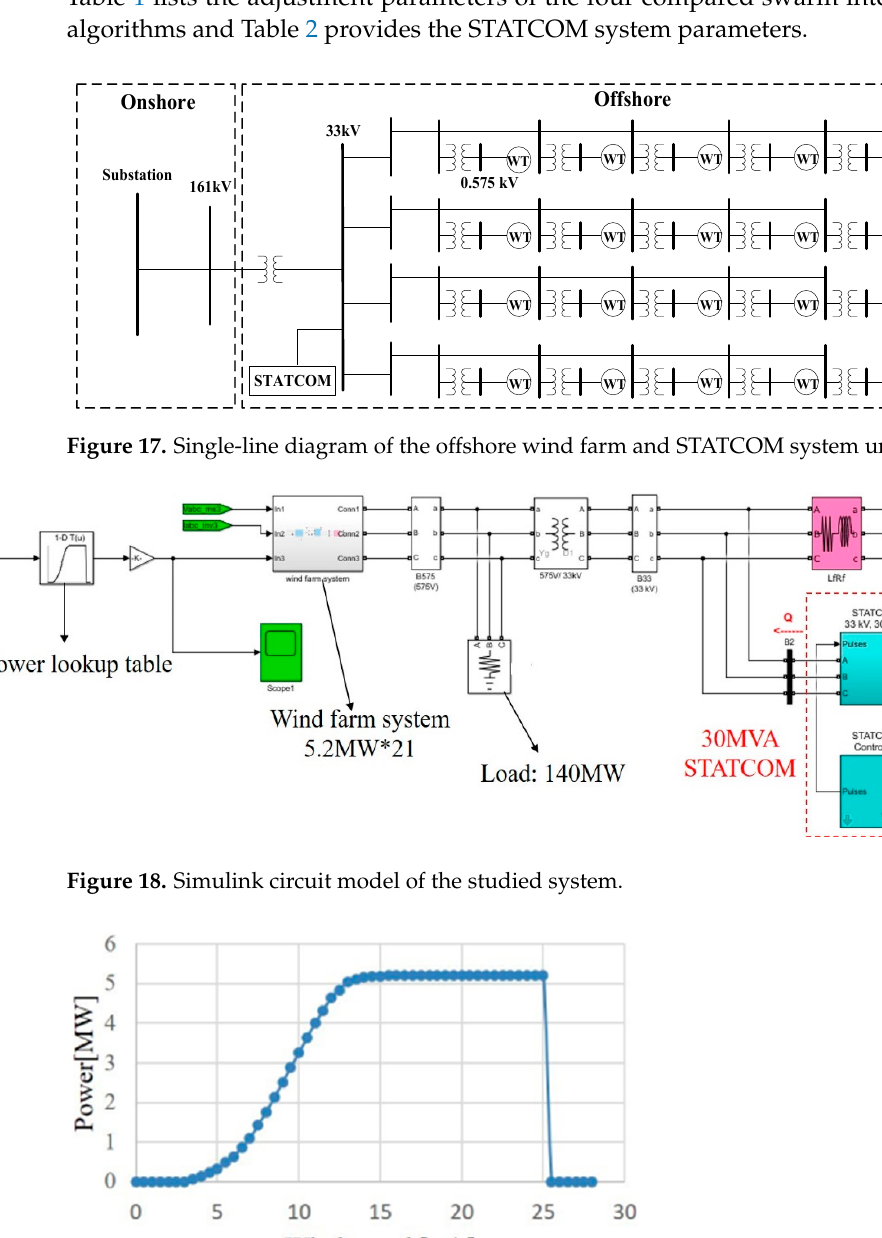
Figure 19. Wind speed vs. power output curve of a 5.2 MW wind turbine.